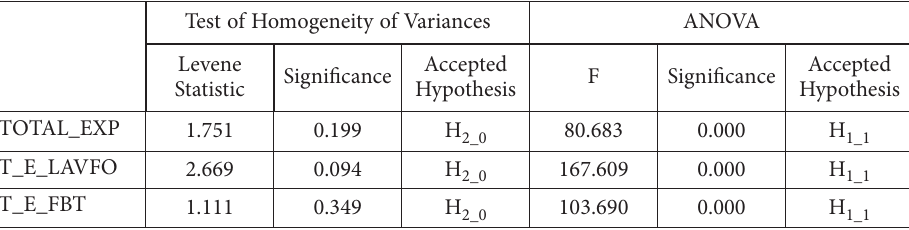
Table 6. The results of testing the statistical significance of Romania’s import volumes average values in the year 2007, at EU states group level (source: authors’ own computations) Test of Homogeneity of Variances